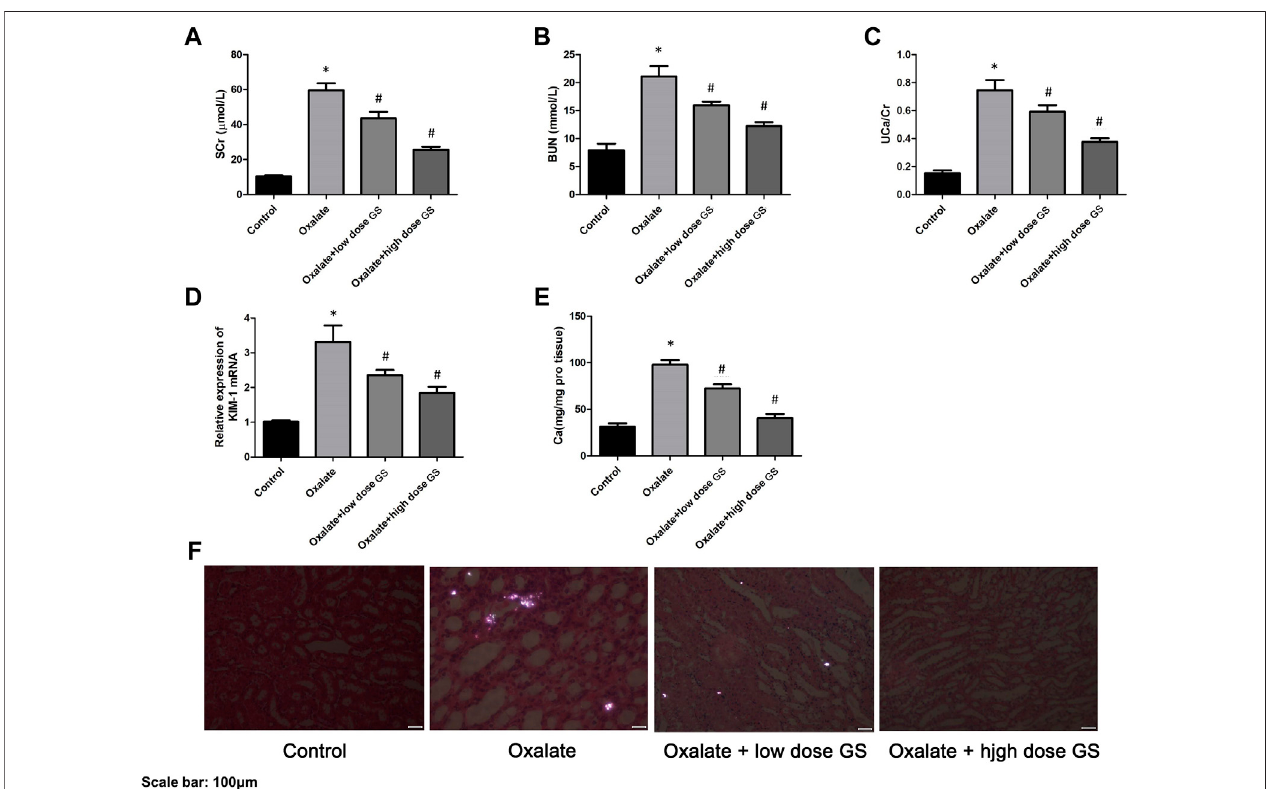
FIGURE 2 | GS protected renal function and alleviated crystal deposition. The levels of SCr (A) and BUN (B) in the serum, UCa/Cr (C) in the urine, renal KIM-1 mRNA (D) and calcium contents (E) in the renal tissues in the control group, oxalate group, oxalate + low-dose GS group, and oxalate + high-dose GS group. (F) Detection of renal CaOx crystal deposition in the four groups with a polarizing microscope. The results are presented as means ± SEM. Statistical comparisons were performed using a Newman-Keuls test (* p < 0.05 compared with the control group and # p < 0.05 compared with the oxalate group).